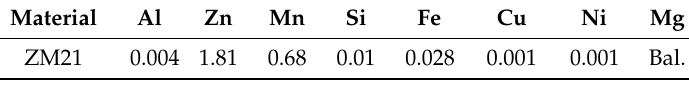
Table 1. Composition of specimens for experiments (mass%).